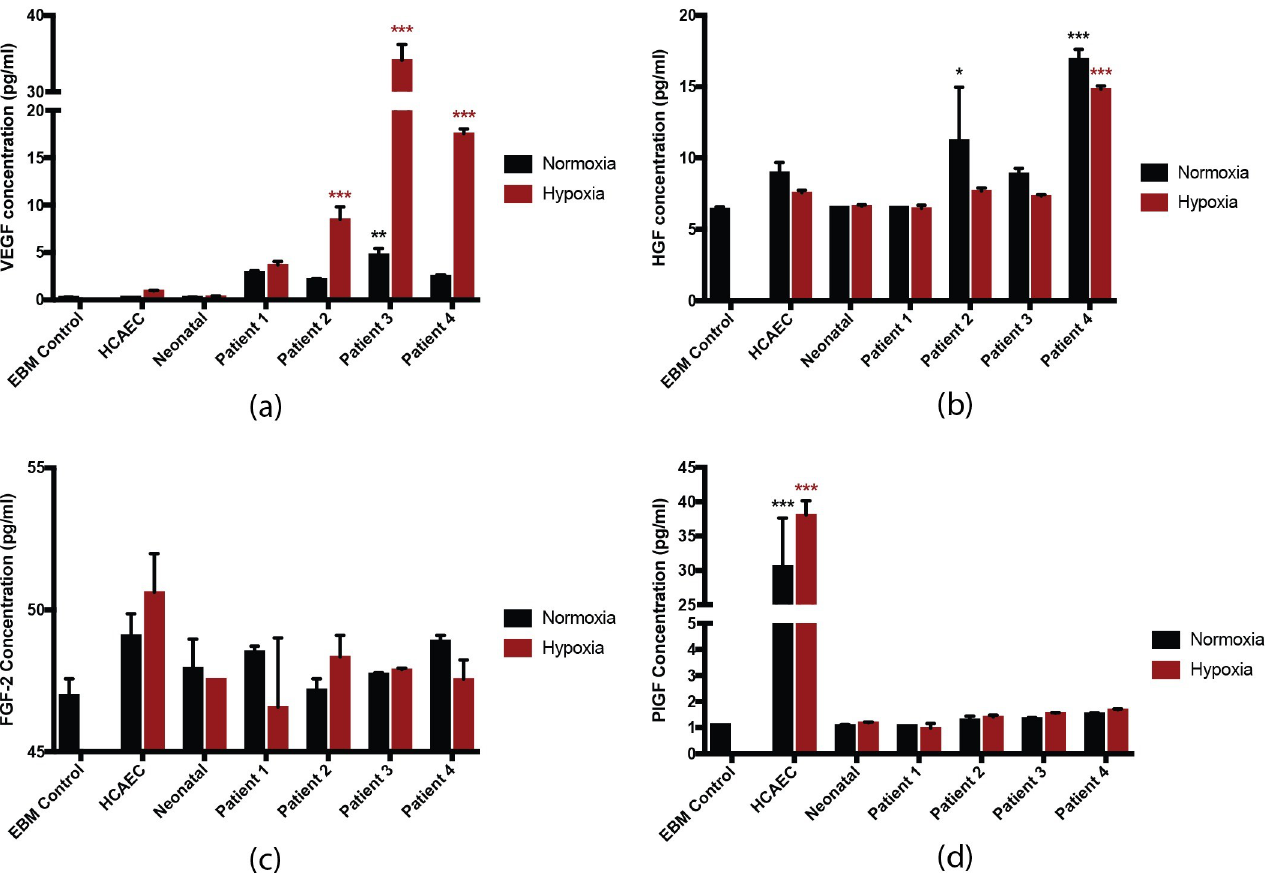
Fig 4. Levels of cytokine concentration detected in conditioned media for iECs. Cytokine concentration after culturing cells in normoxic and hypoxic conditions; (a) VEGF; (b) HGF; (c) FGF-2; (d) PlGF for HCAECs, neonatal-derived iECs and patient-derived iECs under normoxic (black) and hypoxic (red) conditions. Data were analysed by two-way ANOVA and are presented as mean ± SEM. (n = 3 per group, � p < 0.05, �� p < 0.01, ��� p < 0.001 compared to neonatal normoxia; � p < 0.05, �� p < 0.01, ��� p < 0.001 compared to neonatal hypoxia).